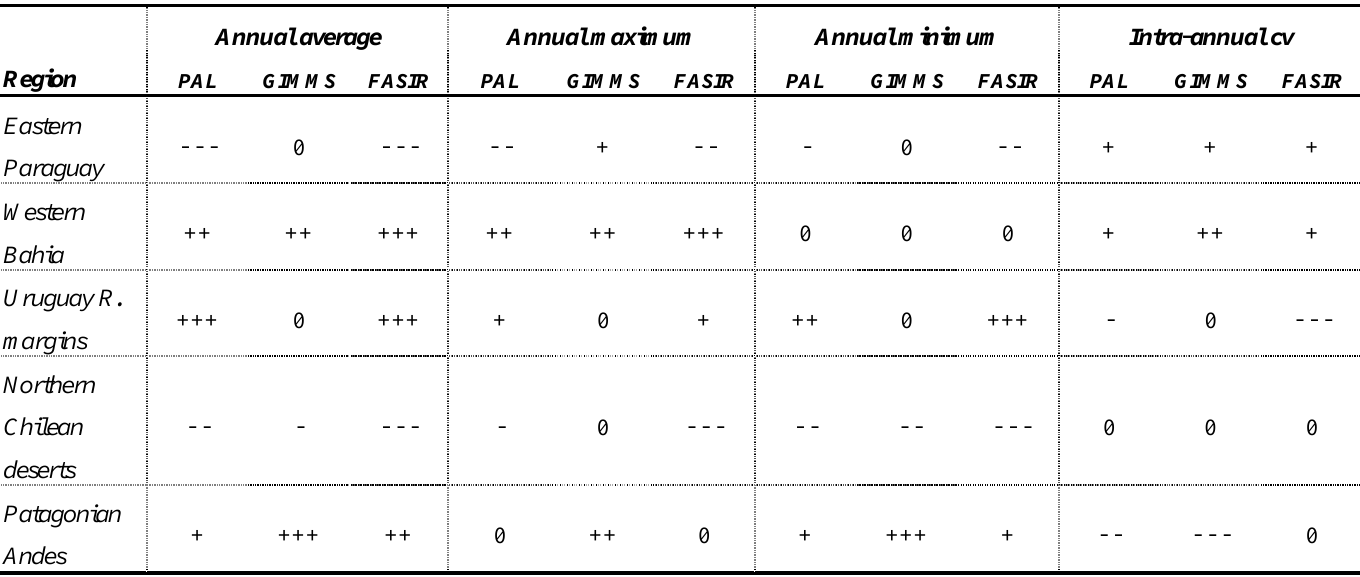
Table 4. Synthesis of the trends for the four NDVI variables in the five focal regions used to evaluate the results. The signs indicate the direction of changes and the approximate area affected by the change (more signs, larger area in the focal region). Acronym: cv, coefficient of